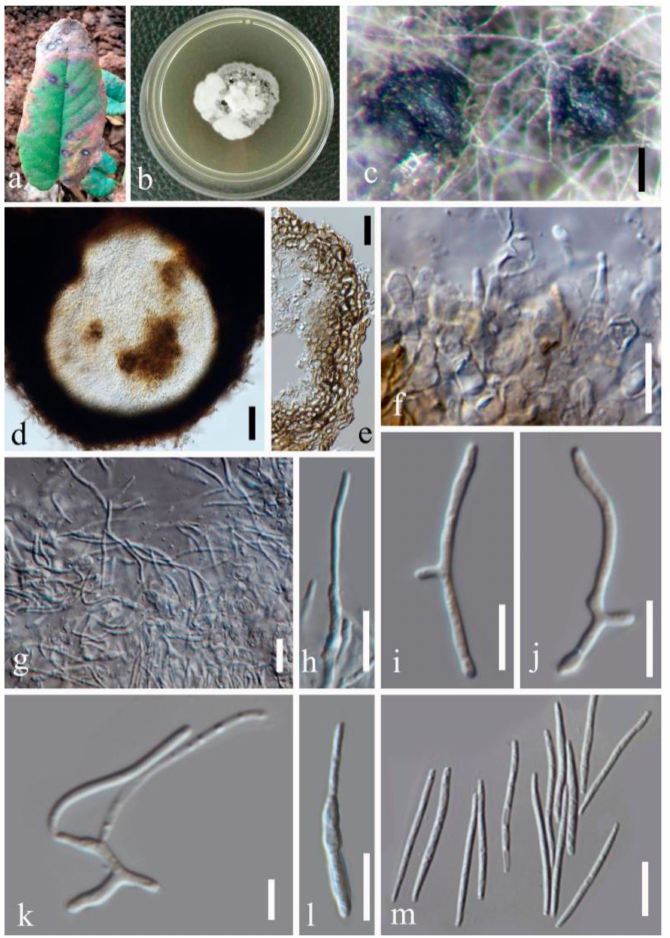
Figure 3. Septoria sanguisorbigena (GUCC 2164.2) ( a ) Leaf spot symptoms on the host. ( b ) Colony on PDA culture. ( c ) Conidiomata formed on PDA culture. ( d ) Section through a conidioma. ( e ) Peridium. ( f – k ) Conidiogenous cells, ( l , m ) Conidia. Scale bars: ( c ) = 25 µ m, ( d ) = 50 µ m, ( e ) = 20 µ m, ( f – j ) = 10 µ m, ( k ) = 5 µ m, ( l , m ) = 10 µ